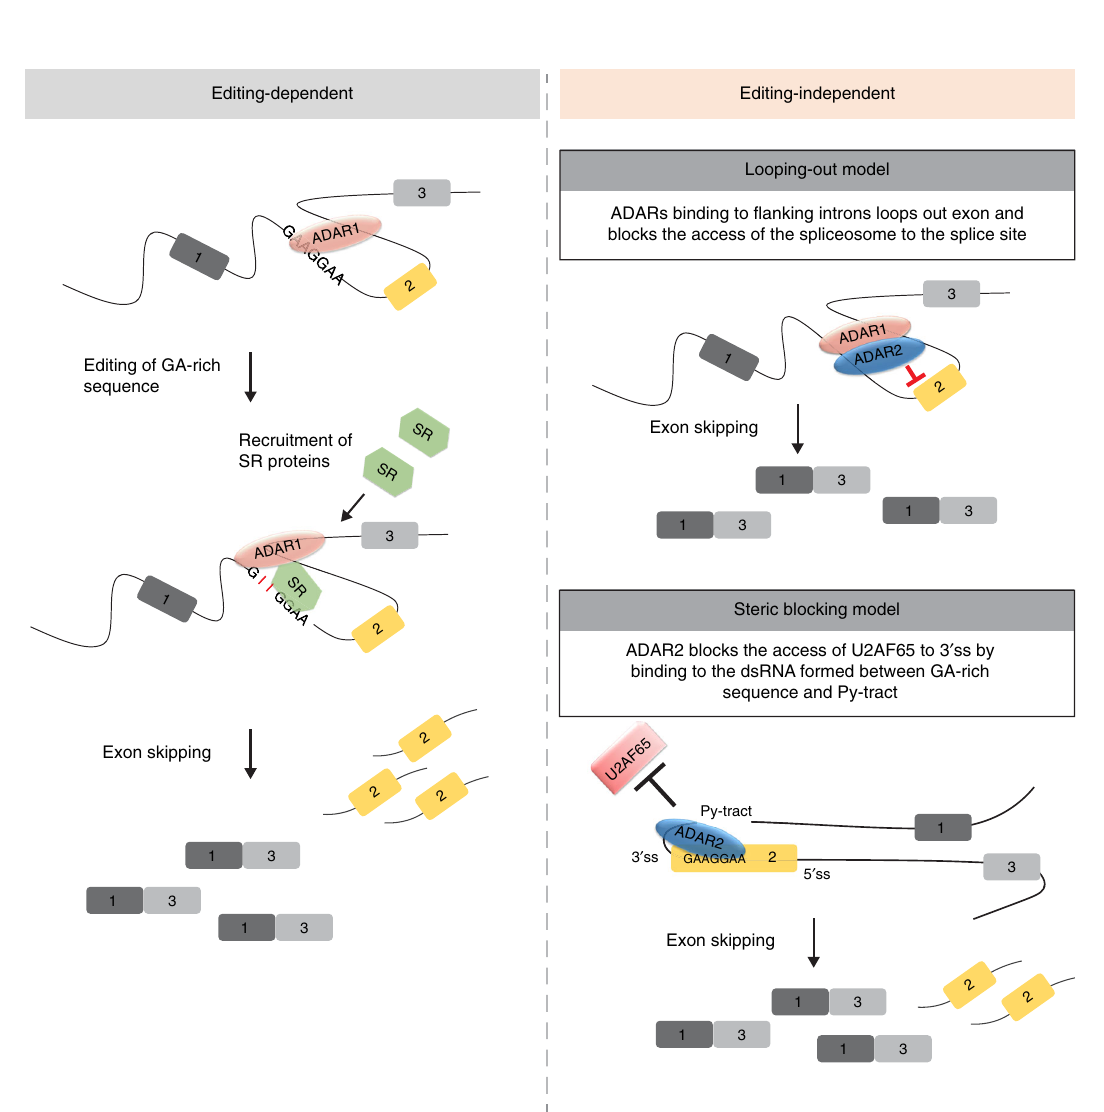
Fig. 9 Schematic mechanistic diagram of ADARs-regulated alternative splicing. Conversion of adenosine to inosine by ADAR1 at a GA-rich sequence proximal to cassette exon of a target transcript recruits SR proteins or other splicing factors to repress exon inclusion. Independent of their editing functions, ADAR1 and ADAR2 proteins can bind to inter-introns of a target transcript, thereby looping out the exon and blocking the access of the spliceosome to the splice site. Alternatively, ADAR2 blocks the access of U2AF65 to the 3 ′ splice site by binding to the dsRNA formed between the GA- rich sequence and